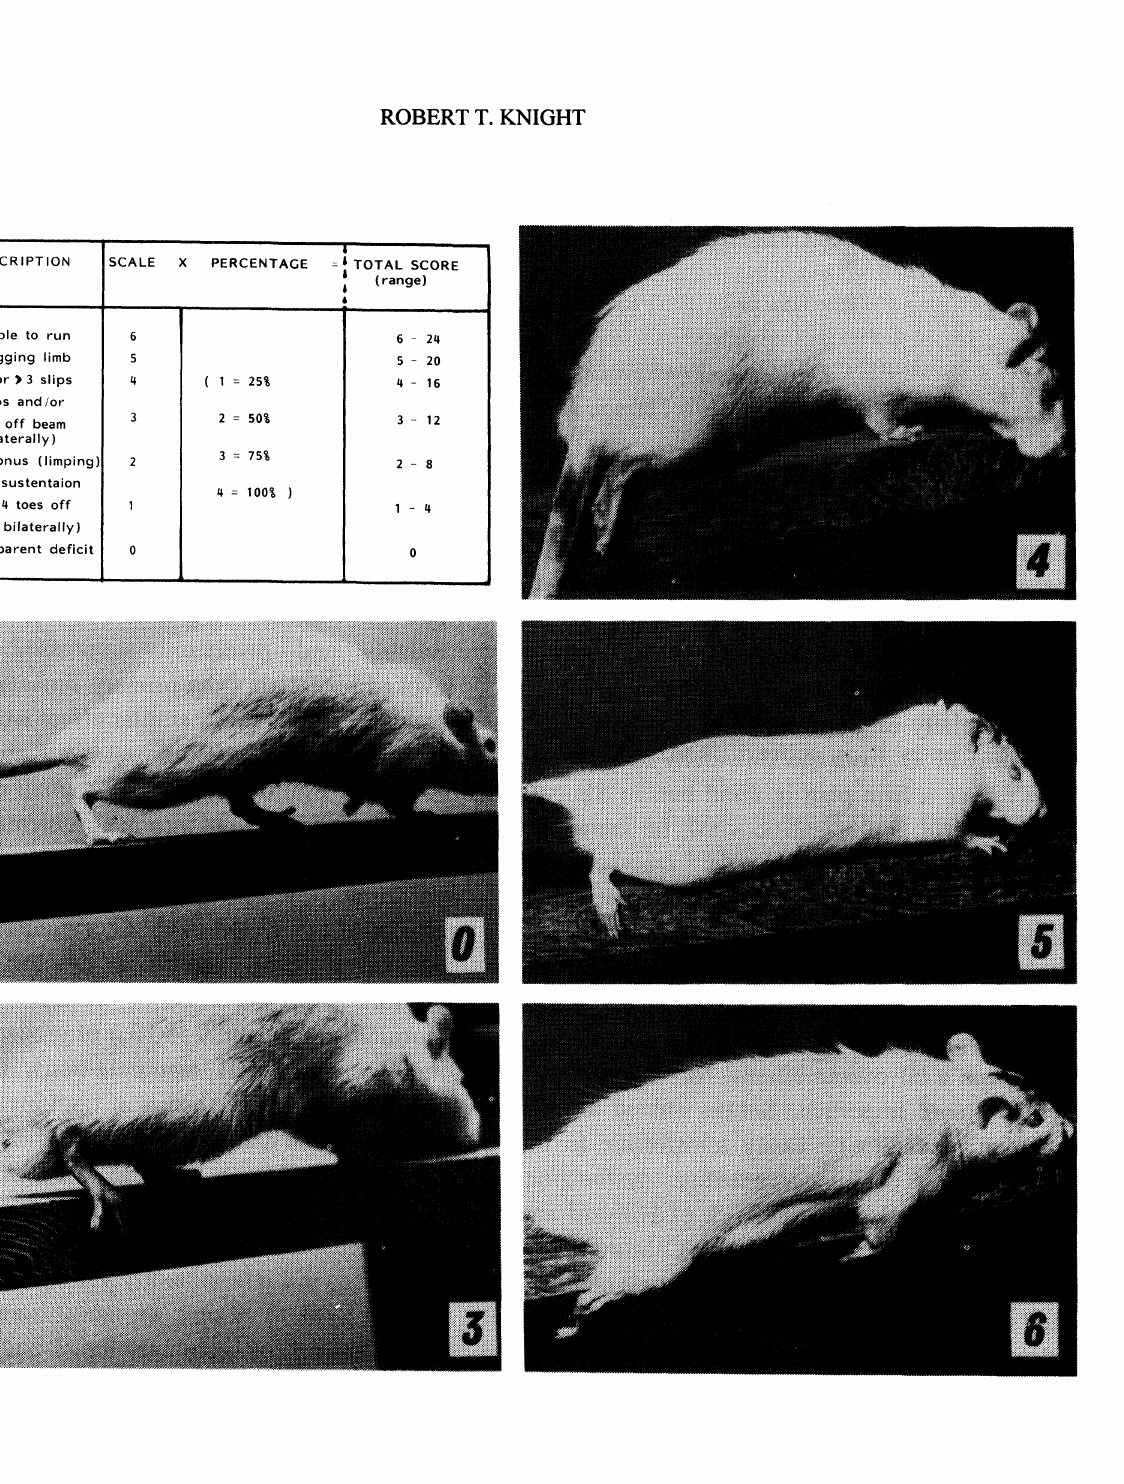
Fig. 1: Scale used for motor behavior quantification. Behaviors (unable to run) and 2 (dragging limb) are not shown in the figure as they are not apparent in a still frame. On the day atter initiation of GABA infusion, the animal was unable to run on the beam and rolled over and lay on the side contralateral to the minipump implanted cortex. This behavior rated the maximum deficit score of 6. An animal received a 5 if it traversed the beam while dragging a hindlimb. A 4 if it fell or traversed the beam slipping off on more than half of its steps, a 3 if it traversed the beam without slipping but with the contralateral hind paw touching the lateral aspect (edge) of the beam, a 2 if the animal limped with one hindlimb (hypotonus) and a if the animal widened its base with the four toes offthe beam bilaterally. Motor behavior was quantified over each quarter section ofthe beam. (from Brailowsky et al.,